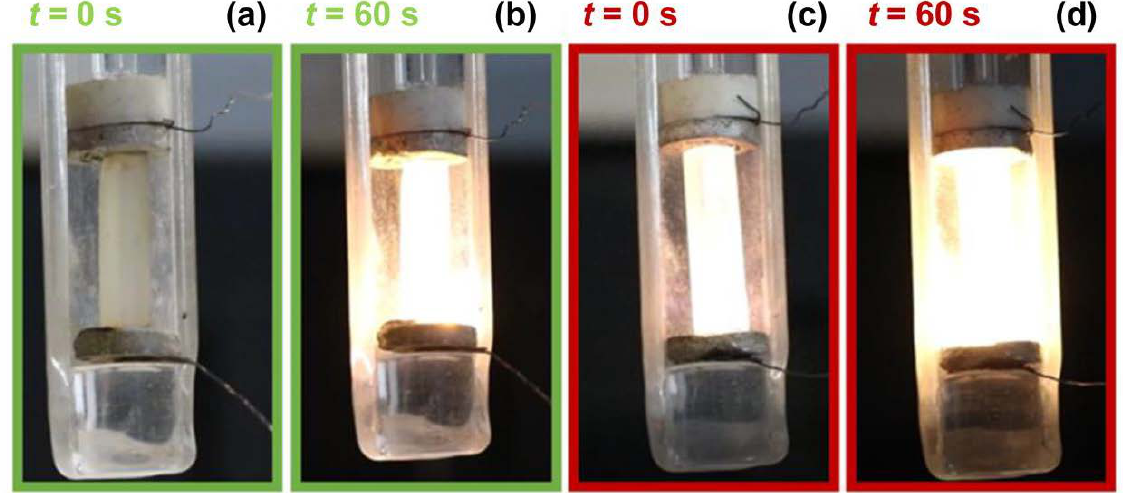
Figure 7. Digital camera images of the ( a , b ) Ag- and ( c , d ) Pt-plated samples treated with 2 mA mm − 2 . The electric current is applied at t = 0 s.